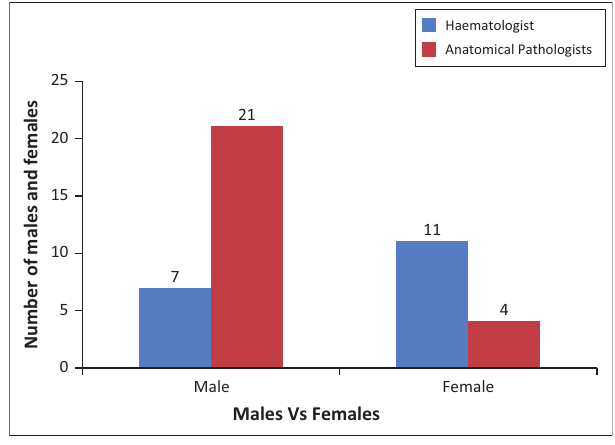
FIGURE 1: Division of gender in the specialisations of anatomical pathology and haematology in